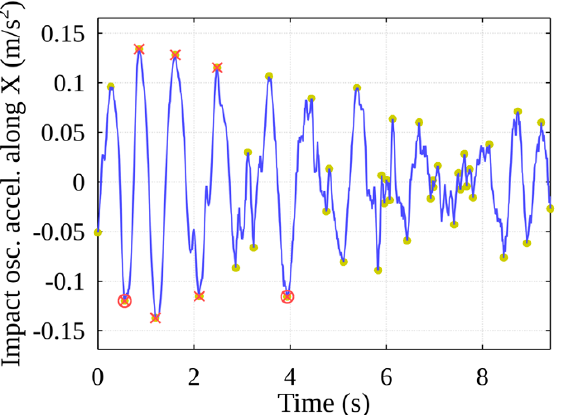
Figure 18. Stage of event detection: event peaks filtered after threshold value is chosen.